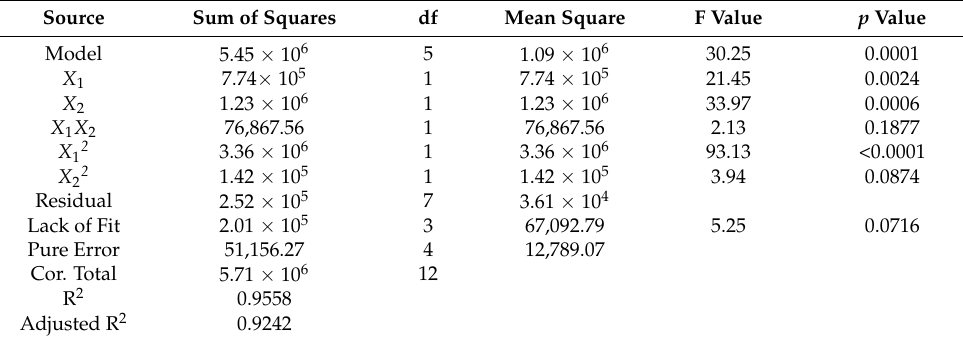
Table 6. ANOVA of the regression model (MAE) for the TBPCs. Source Sum of